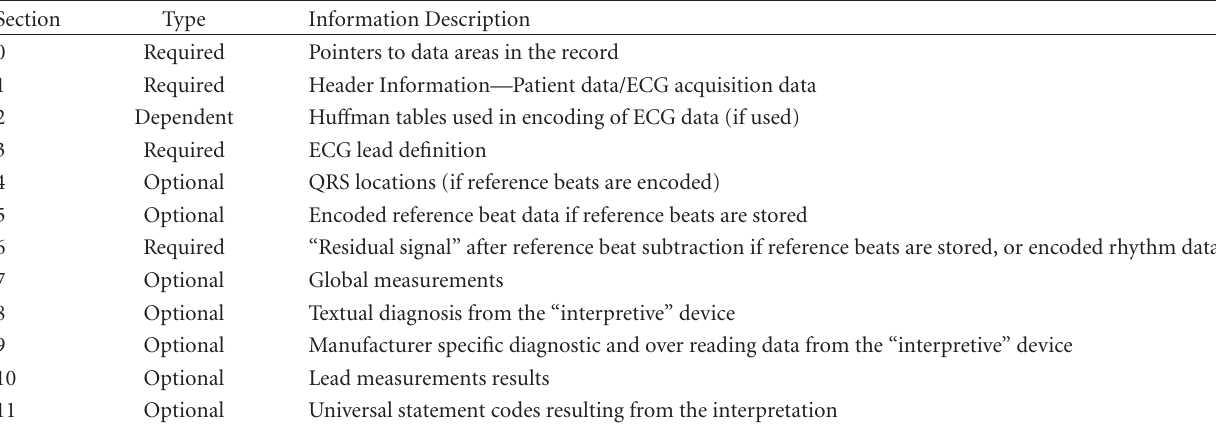
Table 1: SCP-ECG protocol Data